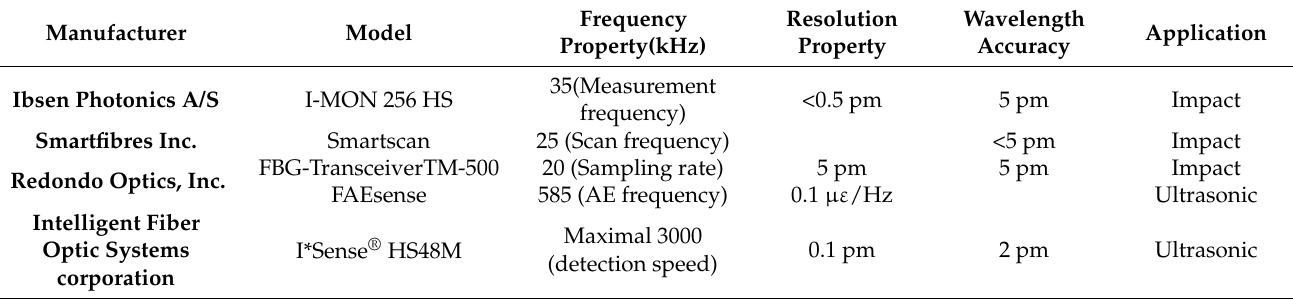
Table 2. The commercial FBG AE interrogators and their specification